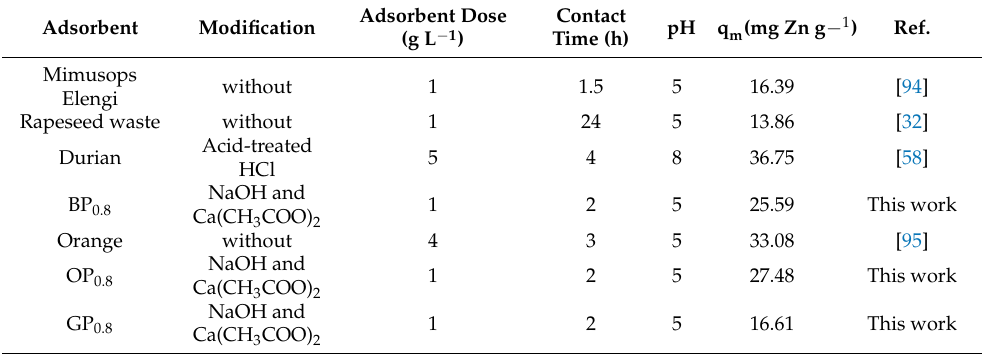
Table 5. Adsorption capacities of various